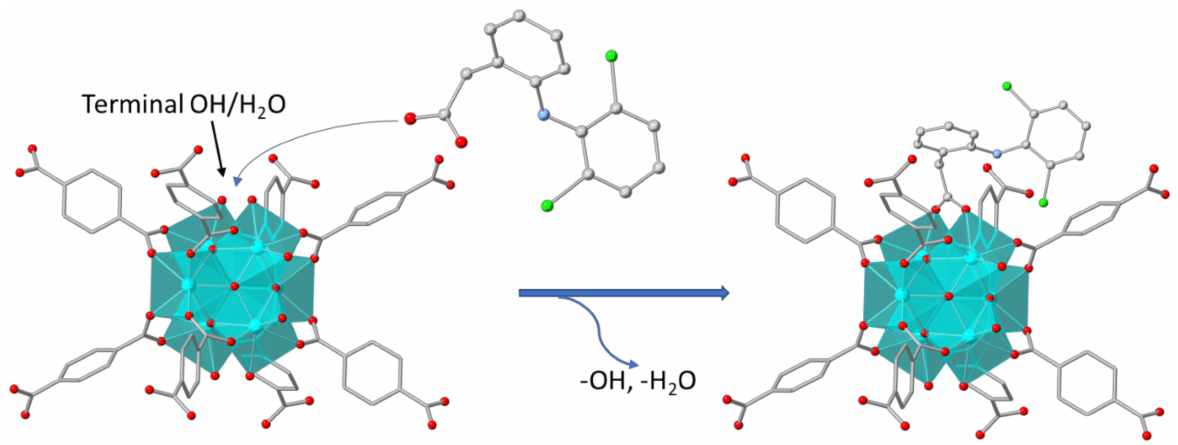
Figure 9. Suggested mechanism for the capture of DCF − by MOR-1/MOR-2 .